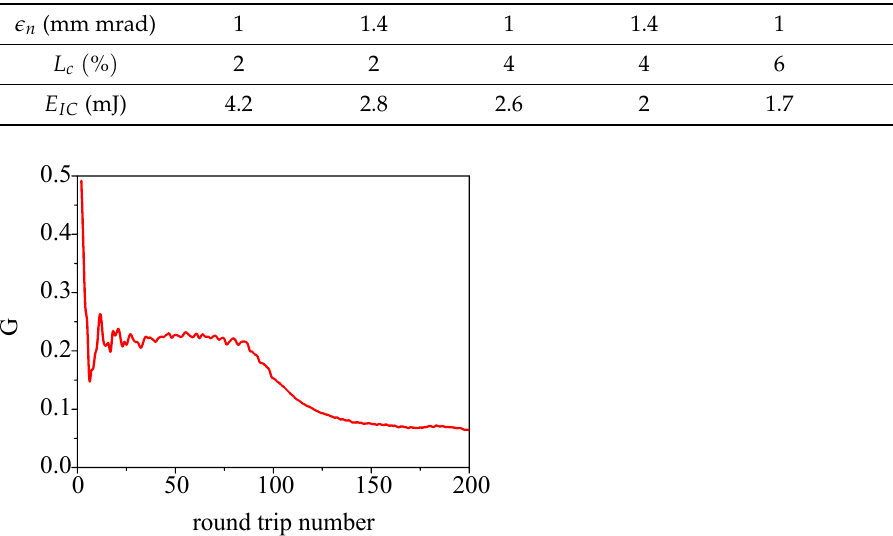
Figure 9. Radiation gain vs. number of round trip for the case with λ = 15 µ m, losses at 6% and emittance of 1.4 mm